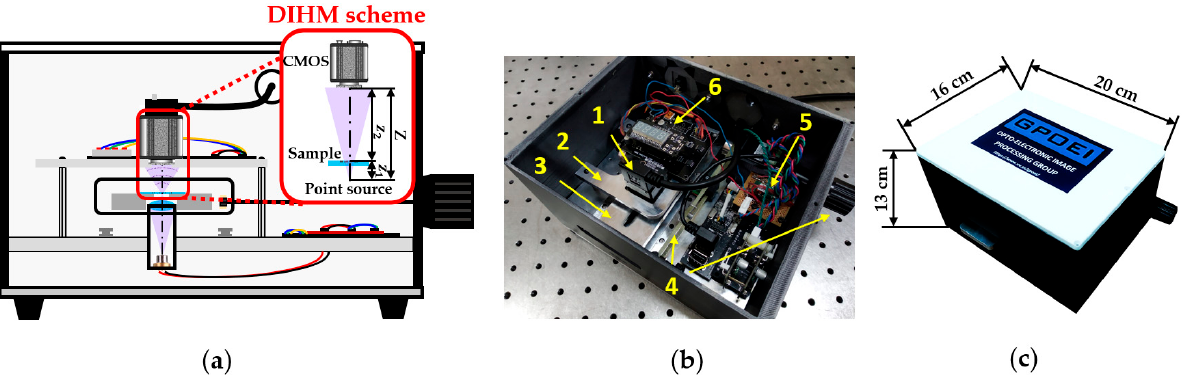
Figure 1. Presentation of the lensless holographic microscope. ( a ) Assembly diagram of a central cross-section of the microscope including the DIHM scheme. ( b ) Perspective view of the microscope once the top cover is taken off. ( c ) Global view of the microscope with external dimensions.